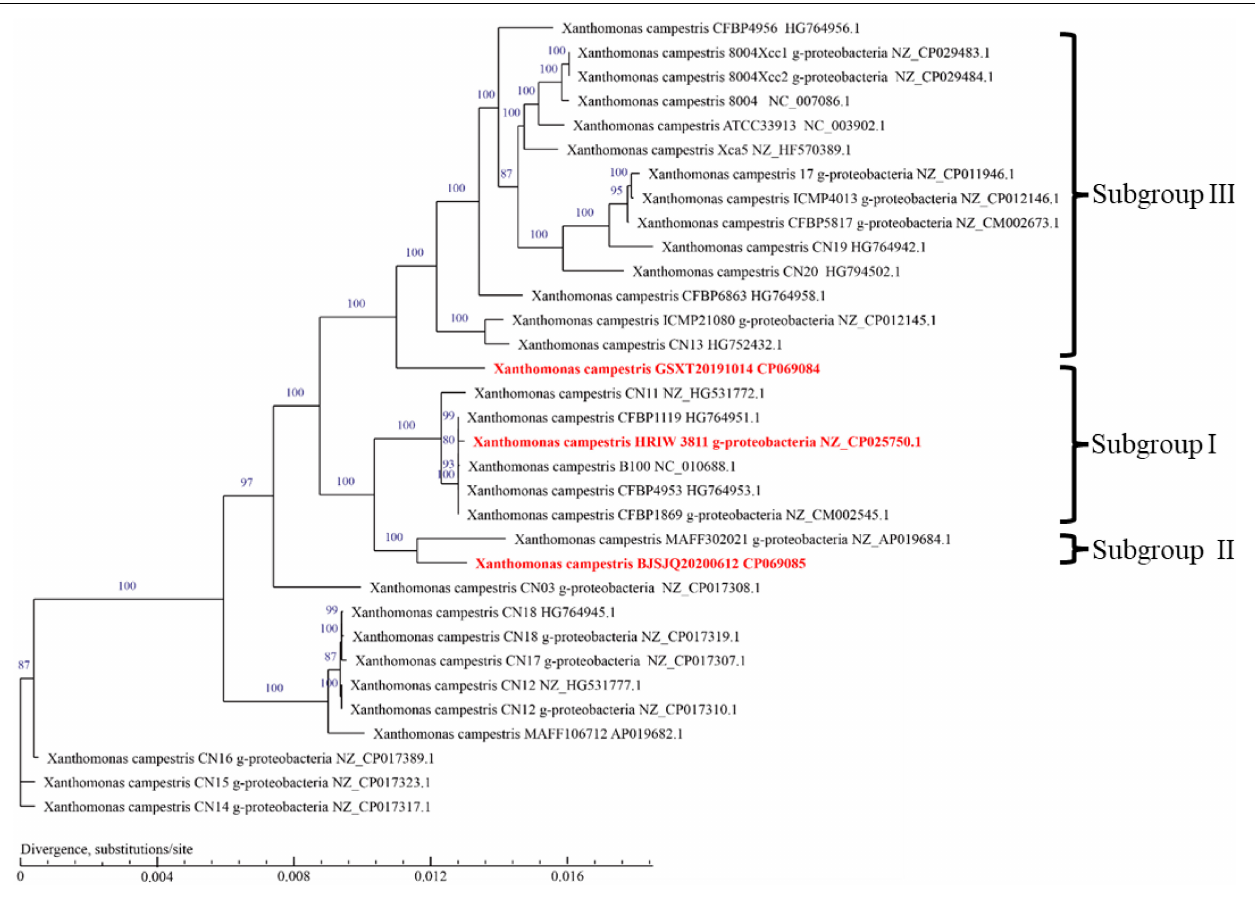
FIGURE 5 | A phylogenetic tree with bootstrap values (1,000 bootstrap replications) reconstructed using the concatenated amino acid sequences of Xcc core-genome showing the relationships among Xcc strains. Strain names as described in GenBank are used in the tree and the type strains are highlighted in red bold. The bar indicates divergence, substitutions per